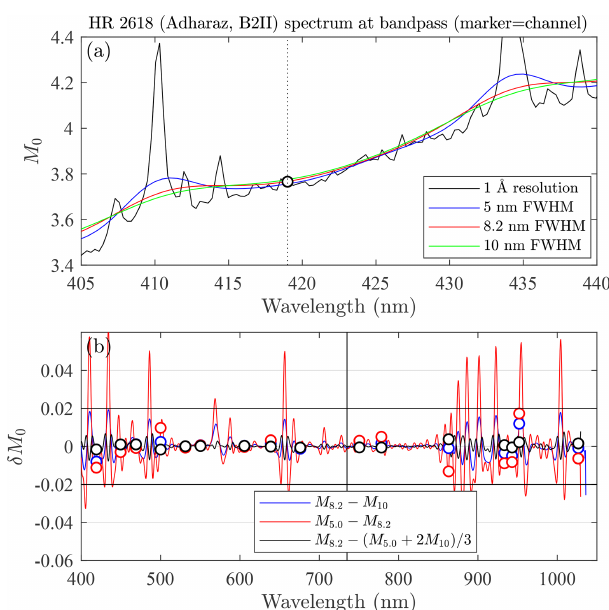
Figure 7. Bandwidth mismatch error for a star of (early-type) spec- tral class B (Adharaz, HR2618). Open circles are nominal starpho- tometer channels.